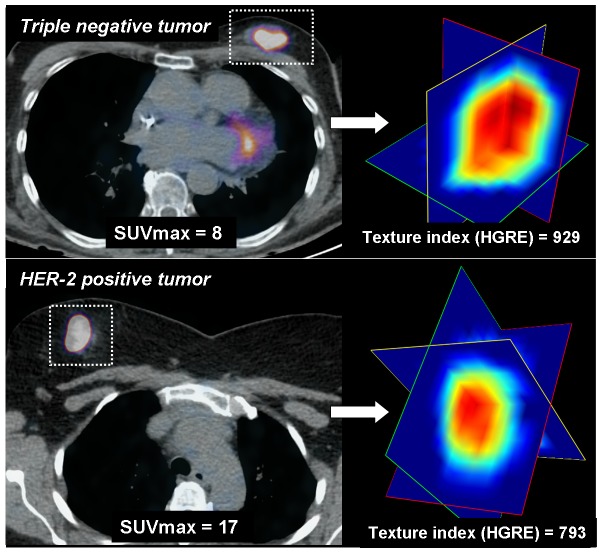
Axial PET fusion images (left) and 3D-view of 3 orthogonal plans from the tumor volume (right) after voxel resampling are displayed.The triple negative breast tumor (top) exhibits lower SUVmax but higher textural heterogeneity than the HER-2 positive breast tumor (bottom). This example illustrates the ability of the HGRE textural index to identify higher heterogeneity despite lower FDG uptake in triple negative breast tumors compared to the non-triple negative breast tumors.